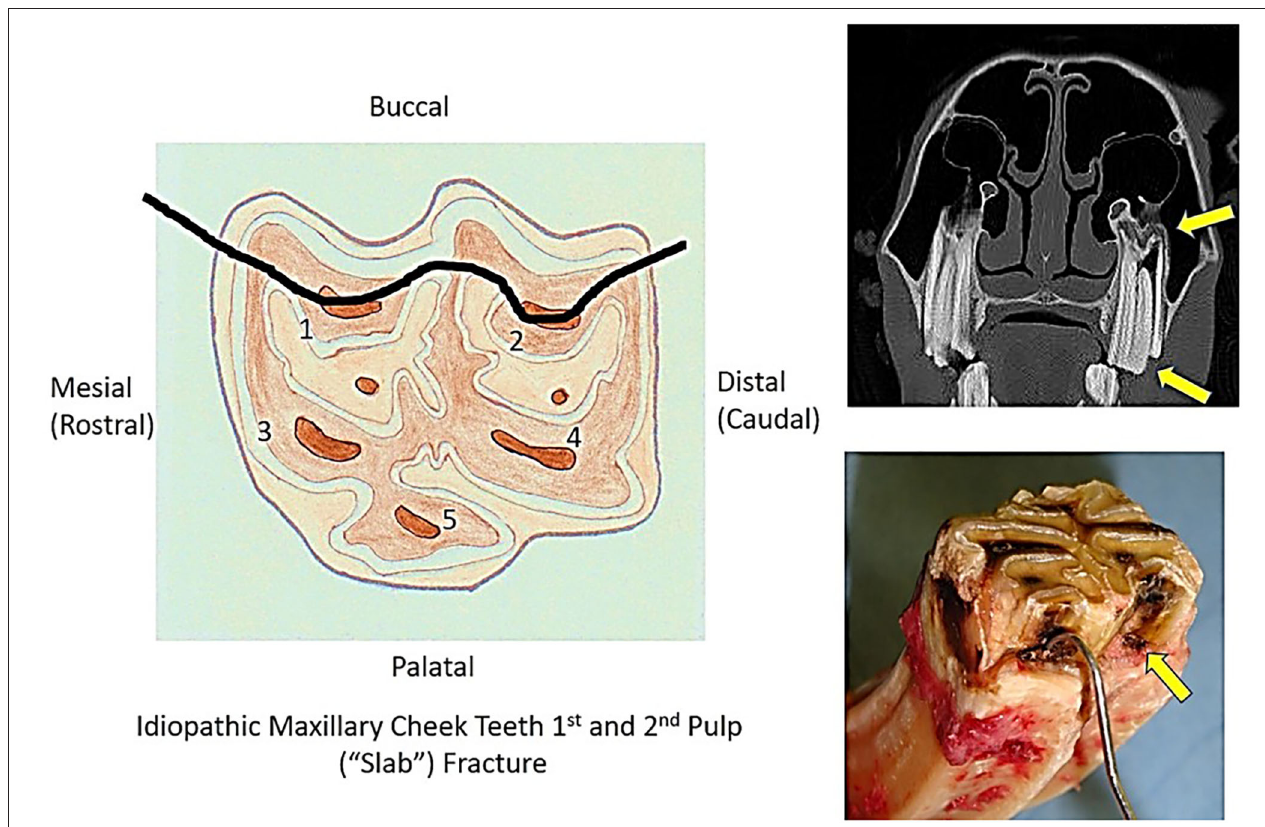
FIGURE 2 | The diagram on the left shows the maxillary cheek teeth pulp horn positions and the site of a fracture plane through pulp horns 1 and 2 (buccal “slab” fracture). Top right is a transverse computed tomographic image of a young Triadan 209 with a buccal “slab” fracture (bottom arrow). There is a resultant apical infection as evidenced by hypoattenuation of an affected pulp horn and, more so, of the common pulp chamber. The affected alveolus and the overlying maxillary sinus mucosa are remodeled and swollen, respectively (top arrow). The bottom left image shows a fractured maxillary cheek tooth extracted because of clinical apical infection. It has occlusal pulpar exposure of the first pulp horn (containing probe) and the second pulp horn